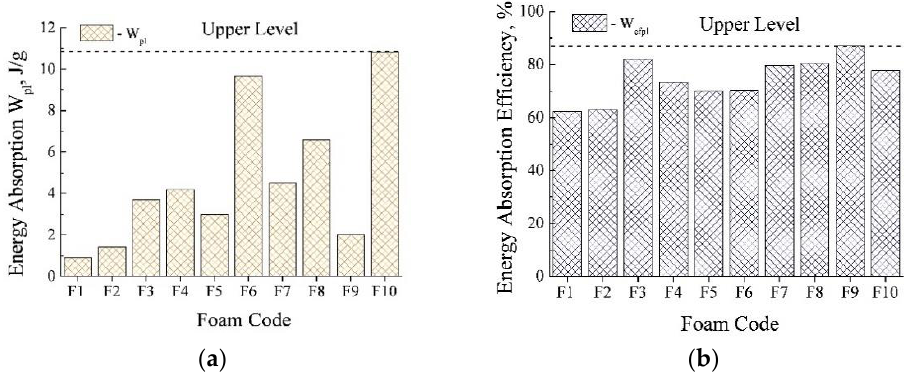
Figure 4. Basic data for ( a ) energy absorption ability W pl and ( b ) its efficiency W efpl for the foams processed with TiH 2 (F1, F3, F5, F7, F9) and CaCO 3 (F2, F4, F6, F8, F10) performed at the comparable ρ / ρ s ≈ 0.22.